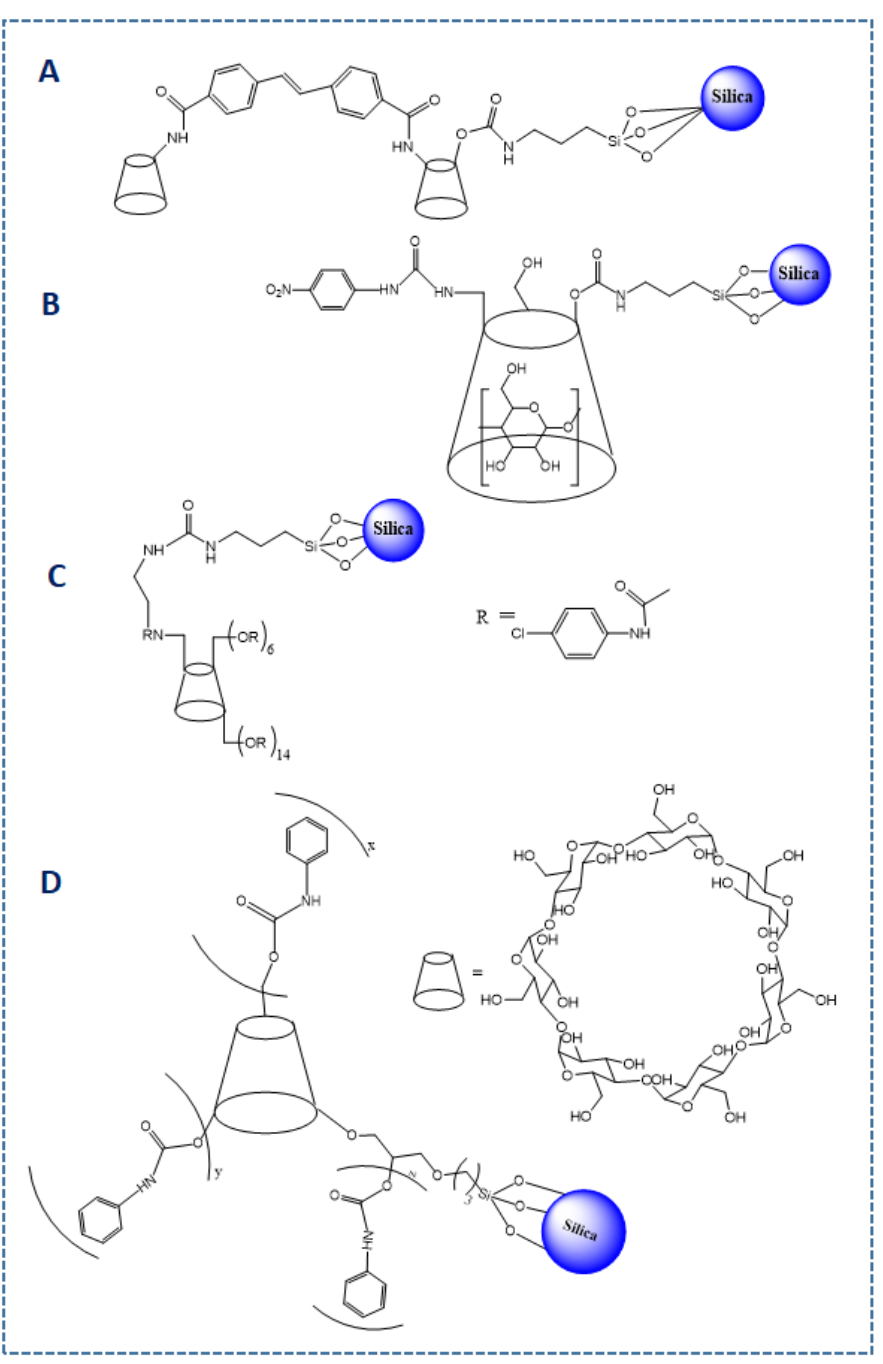
Figure 5. Cyclodextrin-chiral stationary phases ( A – D ) prepared using an isocyanate